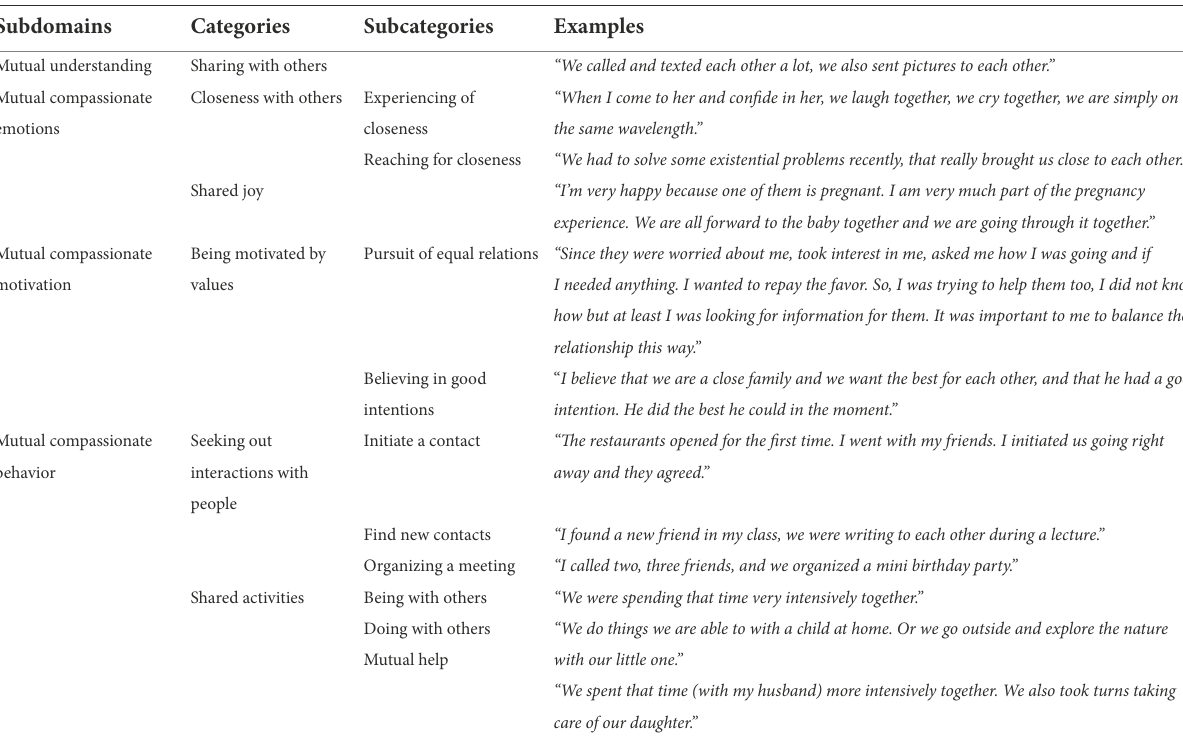
TABLE 3 Categorization of the domain Mutual